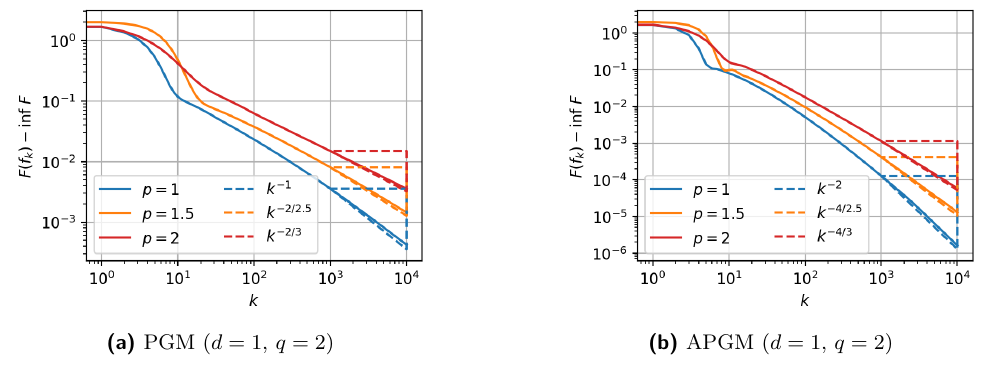
Figure 5 Convergence of PGM and APGM vs. theoretical rates (up to log factors) in a sparse deconvolution problem with H = λ ∥ µ ∥ and d = 1. Here p refers to the parameter of η p and p = 1 refers to η hyp . The objective has structure (II) so q = 2 in the rates of Table